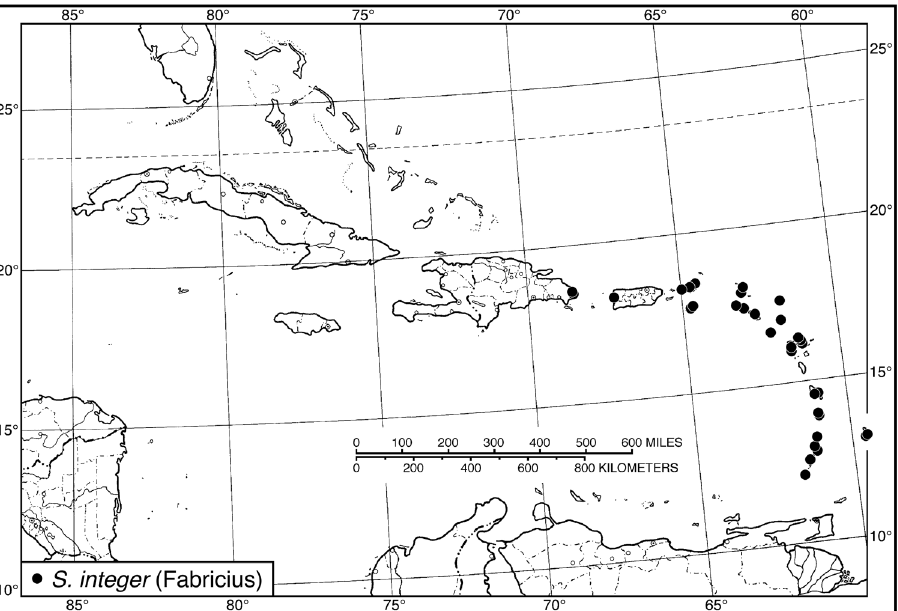
Figure 47. Map of West Indies showing known localities for species of Selenophorus opalinus species group, in